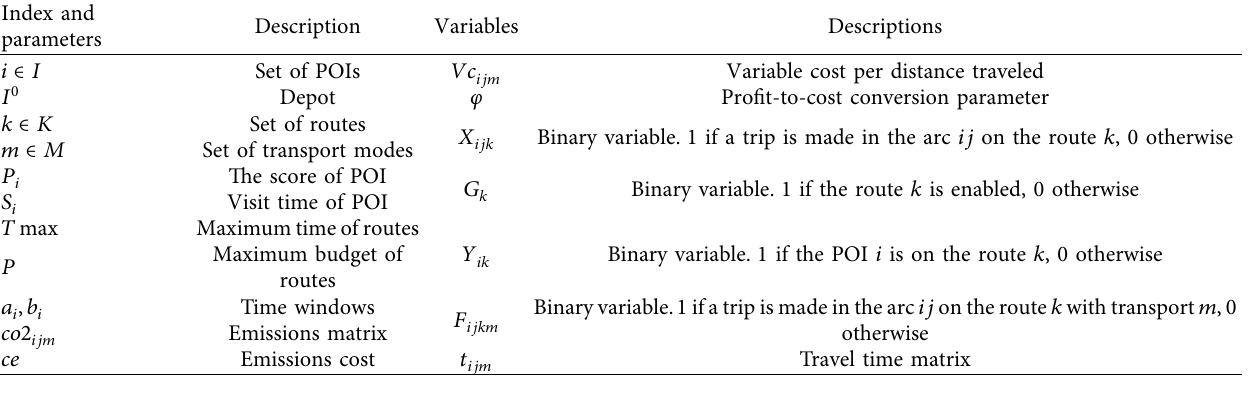
Table 1: Index, parameters, and